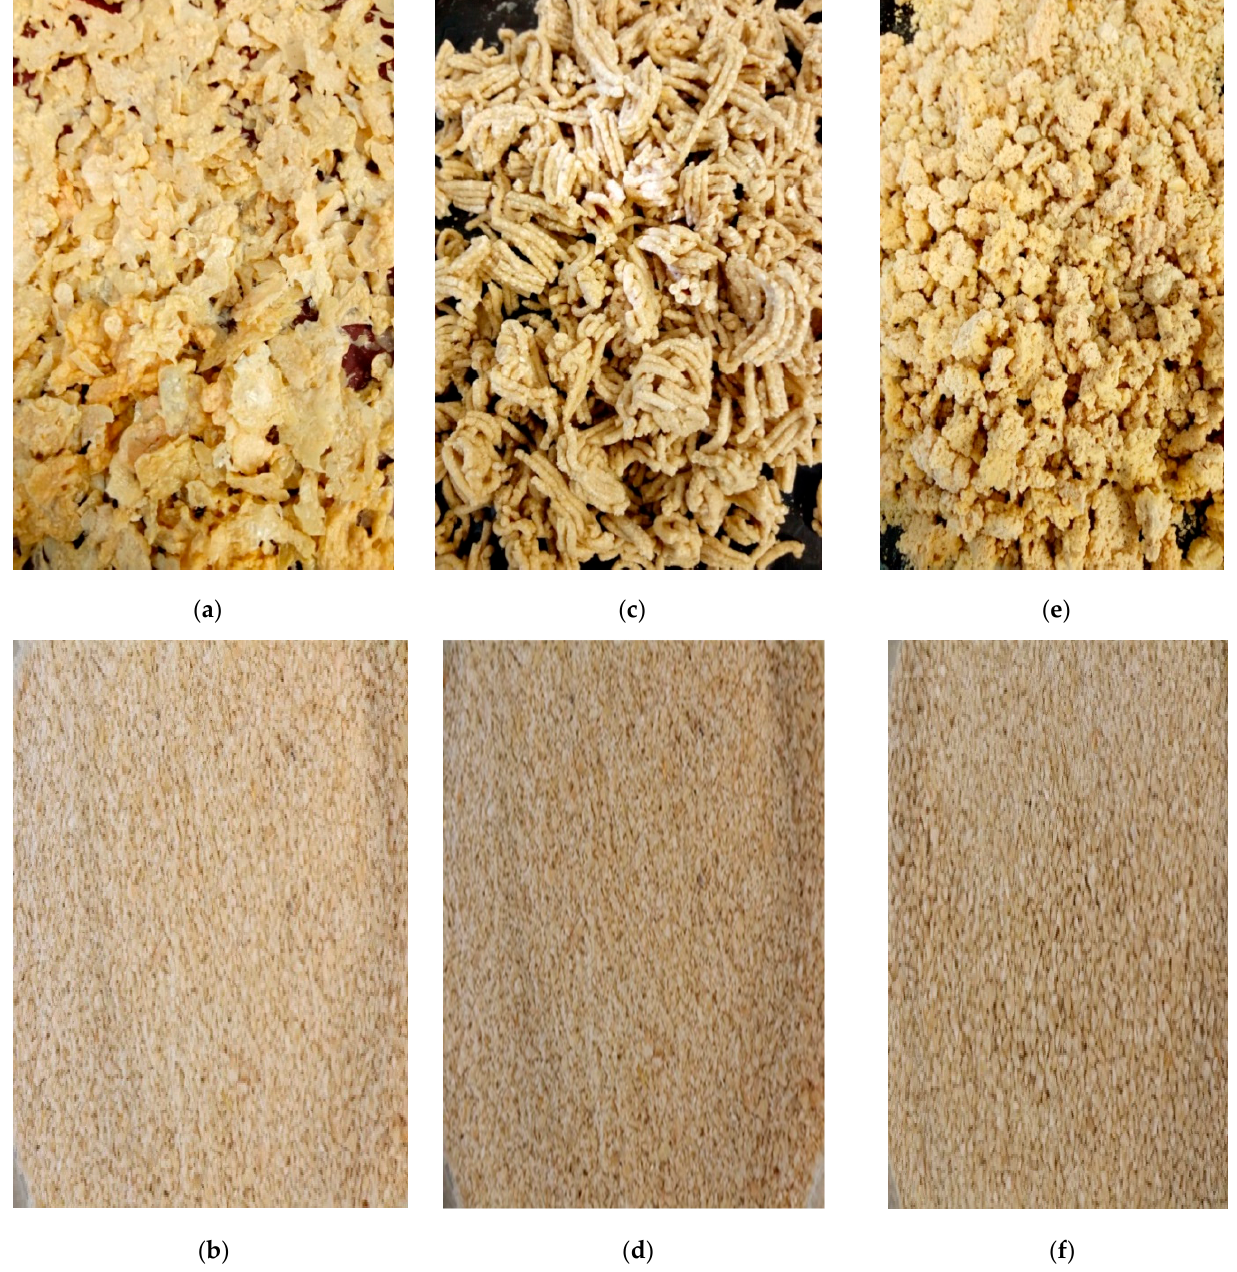
Figure 1. ( a ) Spherified egusi grit unmilled; ( b ) spherified egusi grit milled; ( c ) extruded egusi grit unmilled; ( d ) extruded egusi grit milled; ( e ) boiled egusi grit unmilled; ( f ) boiled egusi grit milled. Table 2. Sensory properties of instant egusi soup mix formulation for the boiled egusi grit.